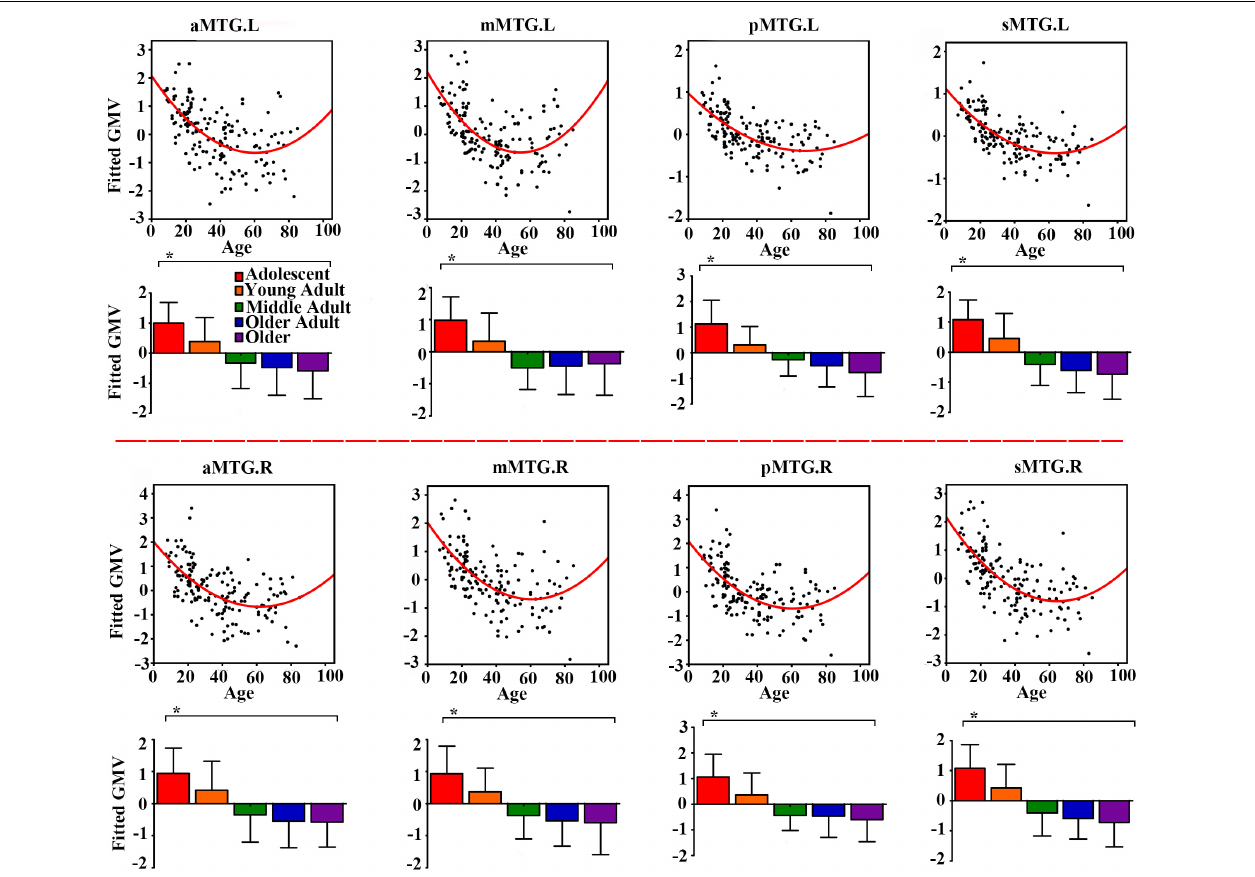
FIGURE 1 | Quadratic relationships between gray matter volume (GMV) of middle temporal gyrus (MTG) sub-regions and age across lifespan. The GMV was fitted by controlling for gender and handedness. The analysis of covariance (ANCOVA) was performed to explore group differences ( ∗ represents significant difference).